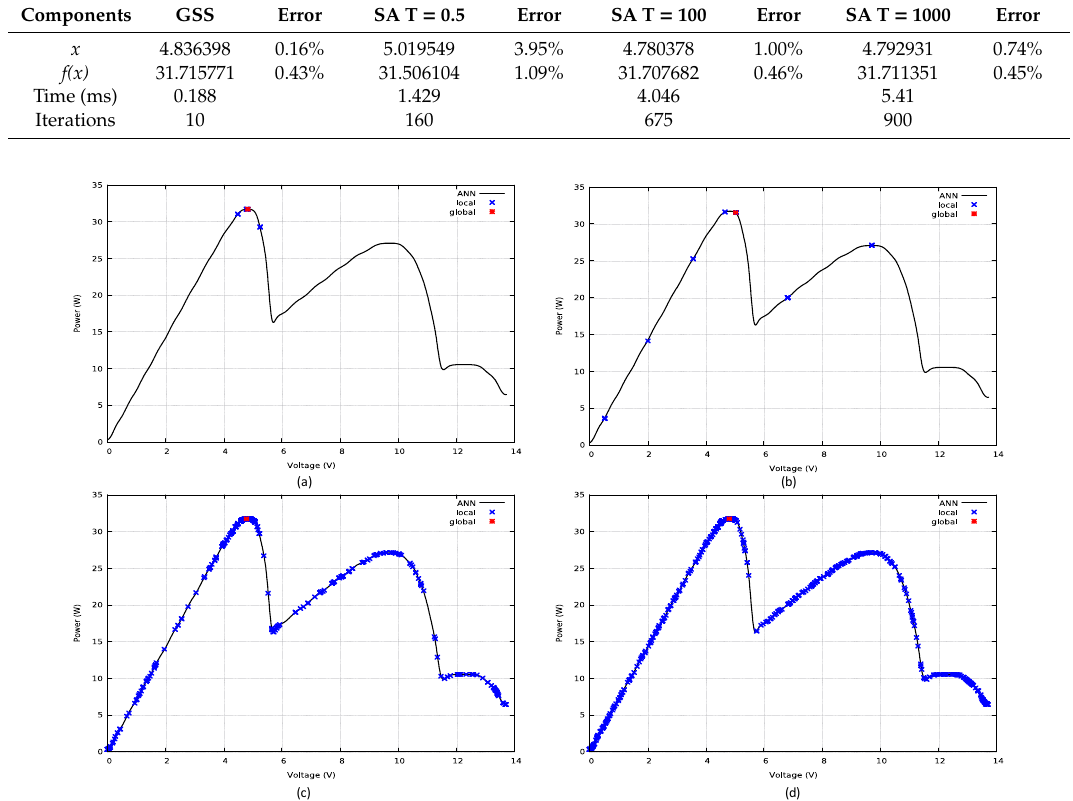
Figure 8. Results obtained with the algorithms for the test function 2: ( a ) GSS; ( b ) SA (T = 0.5); ( c ) SA (T = 100); ( d ) SA (T = 1000). Table 6. Results of the algorithms for the test function 3.